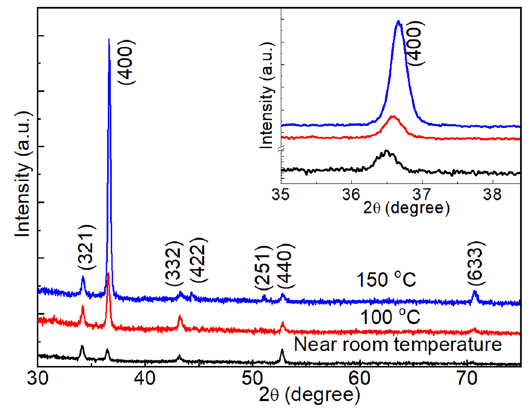
Figure 2: XRD patterns of ZN thin fi lms on glass substrates with temperatures of near room temperature, 100 and 150°C. The inset shows the magni fi ed ( 400 ) di ff raction peaks of the corresponding ZN thin fi lms ( reprinted from ref. [ 31 ])